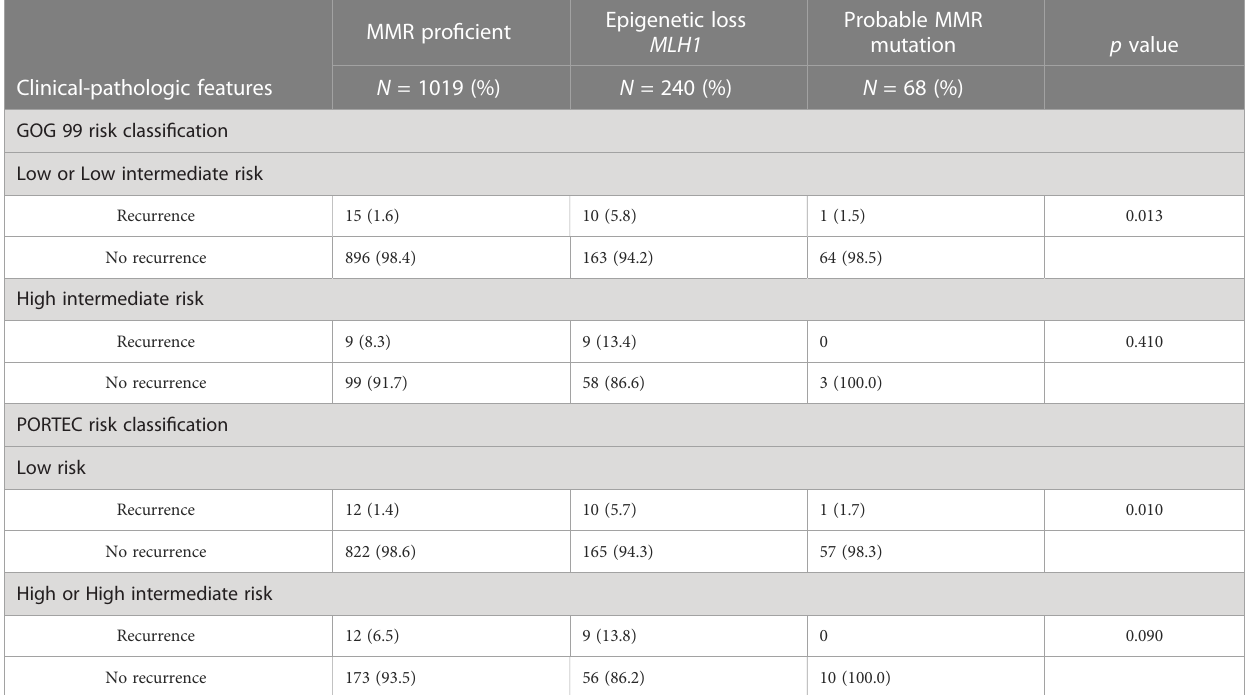
TABLE 3 Recurrence rates early stage endometrioid histology EC by MMR status.